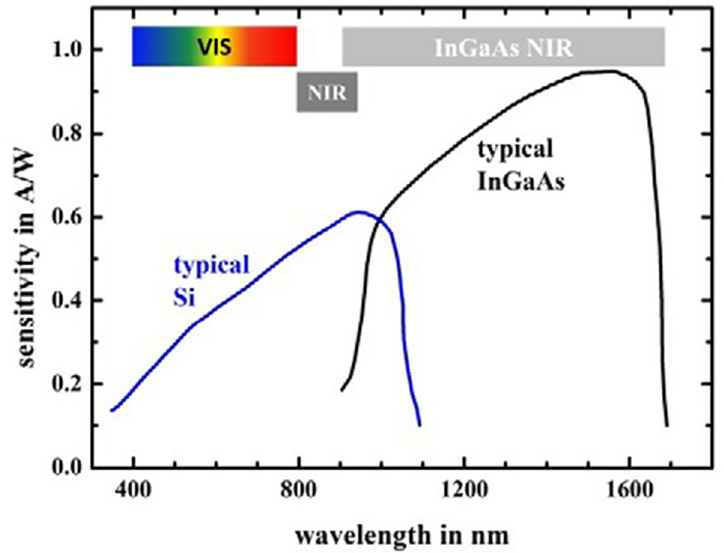
Figure 3. Typical quantum efficiency spectra of Si and InGaAs detectors. The colored and grey bars indicate the visible, SW-NIR, and conventional NIR (named “InGaAs NIR” in the source) wavelength ranges. Reproduced (CC-BY 4.0 license) from [45].